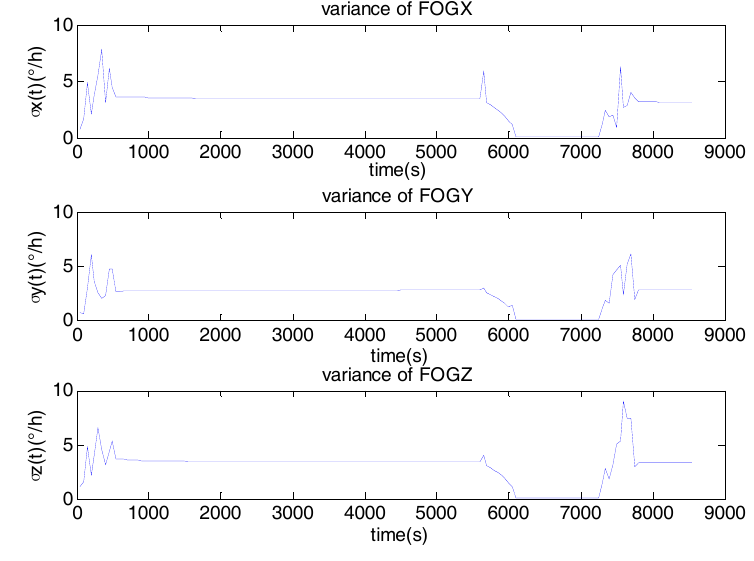
Figure 5. The noise model based on DAVAR. Table 2. The variance of the noise.